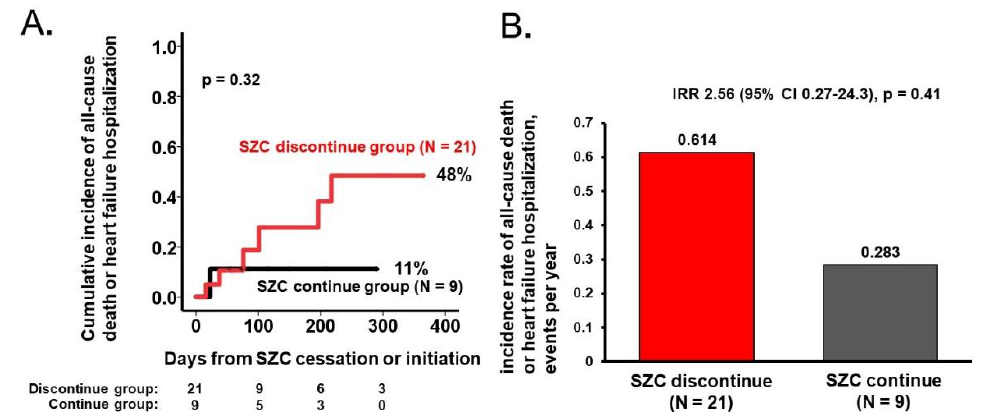
Figure 3. One-year cumulative incidence of all-cause death or heart failure hospitalization following SZC cessation/initiation ( A ). Incidence rate comparison between the SZC continue and SZC discon- tinue group ( B ). Log-rank test for time-to-event analysis and negative binomial regression analysis for incidence rate comparison. IRR, incidence rate ratio; CI, confidence interval.